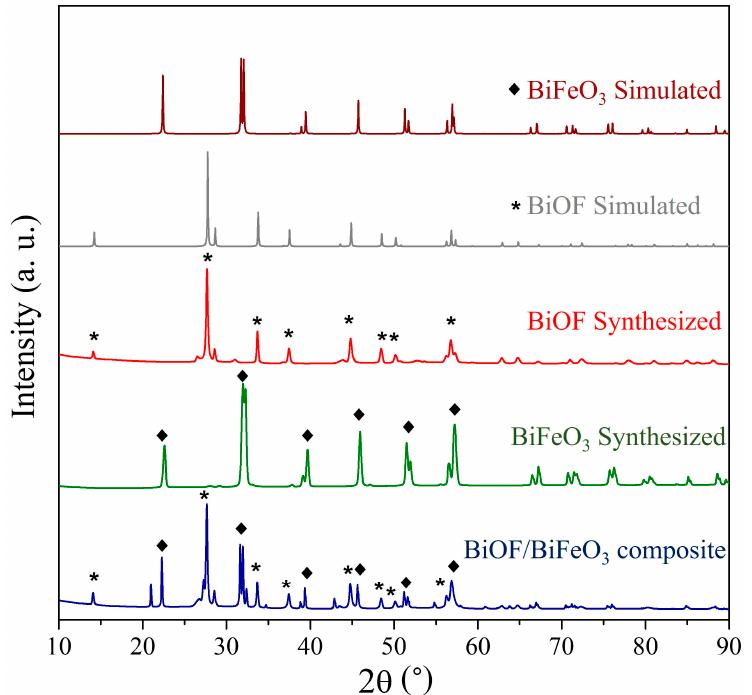
Figure 1. XRD pa tt erns of the synthesized photocatalysts. BiFeO 3 is presented by ( ⬥ ) and BiOF is presented by ( * ).